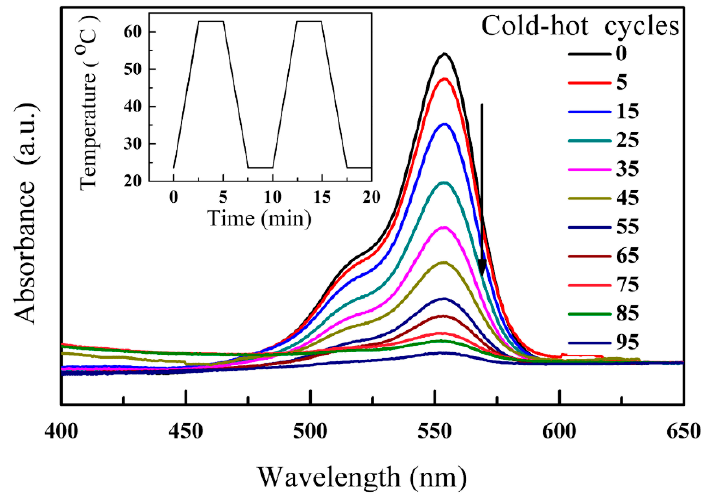
Figure 5. The adsorption spectrum of RhB dye solution with BNT. The inset shows the time curve for the cold-hot cycle.